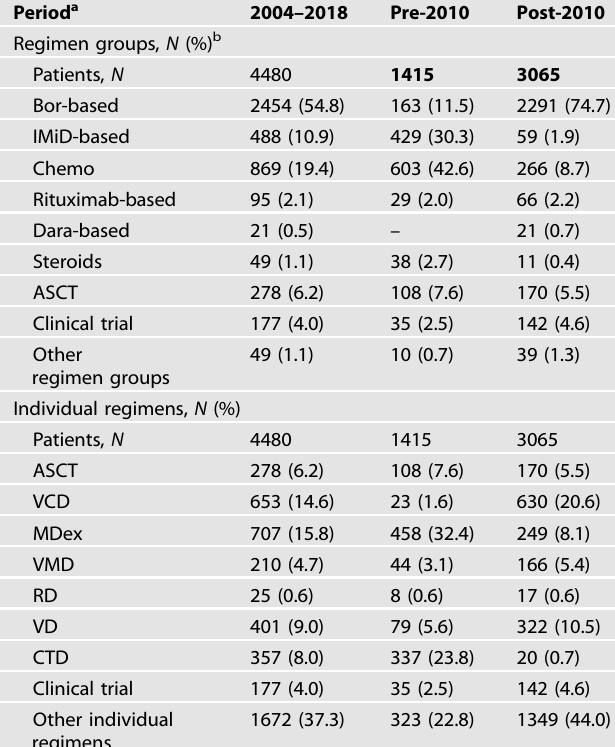
Table 3. Second-line treatment regimens, overall (2004 – 2018), and by fi rst-line treatment initiation period (pre- and